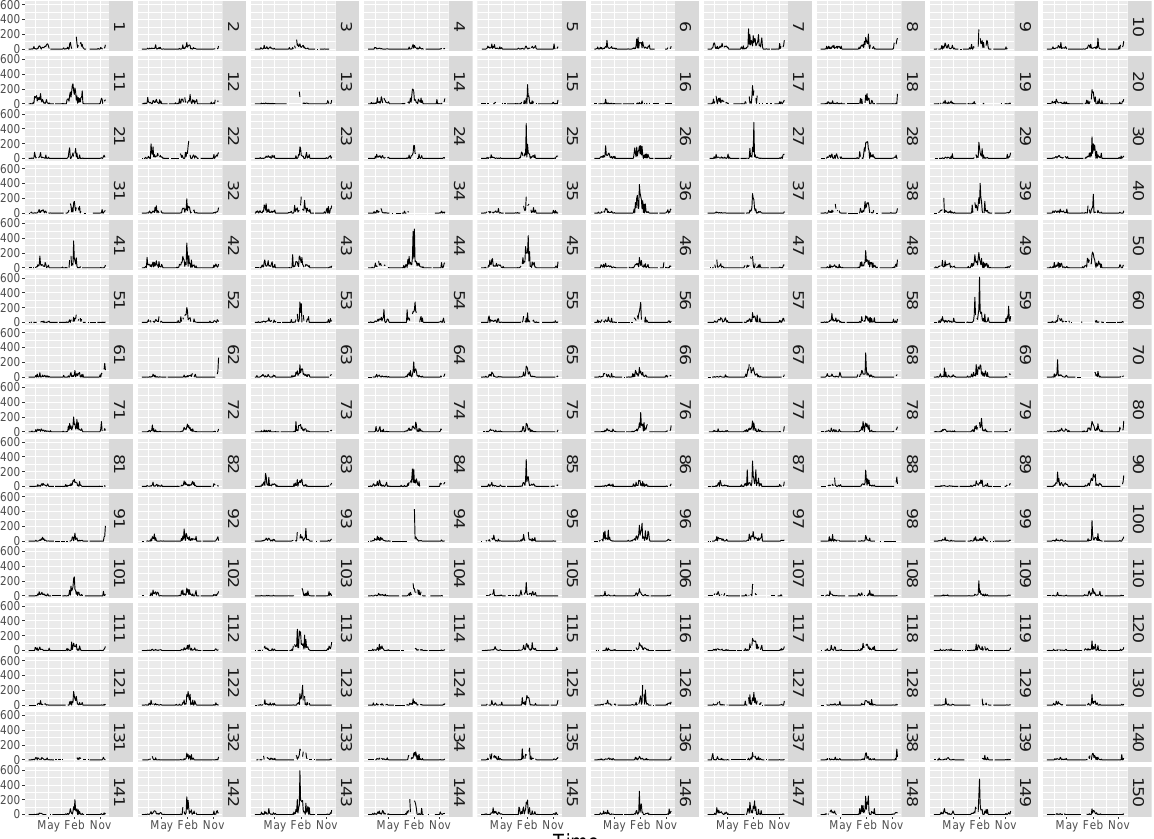
Figure 2. Time series plots of average egg counts as measured by 300 ovitraps distributed in 150 houses in Córdoba (Argentina). Period: September 2017–December 2019. Numbers 1 to 150 represent the houses where ovitraps were placed. Houses number 13, 19, 34, 60, 70, 131 and 139 were excluded of further analyses because they presented more than 10 consecutive time steps without